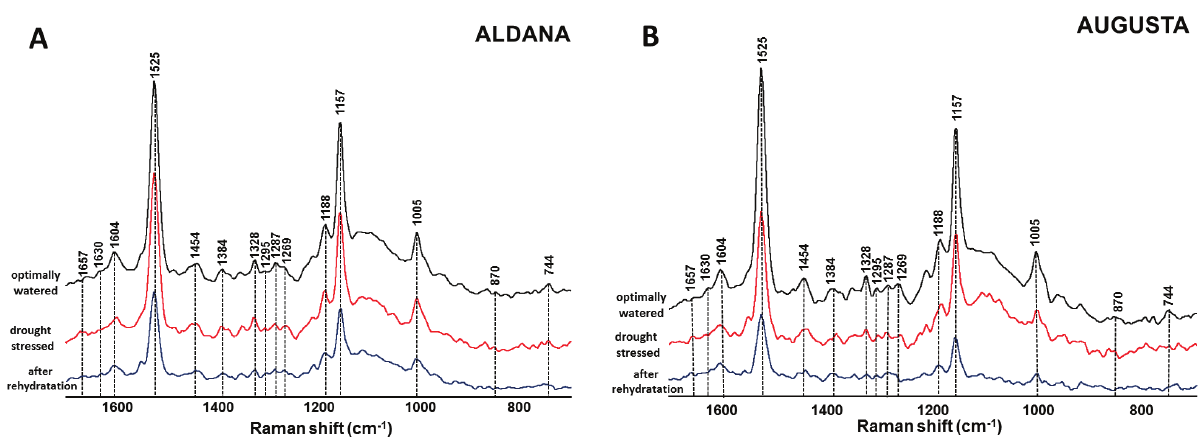
Figure 1: FT-Raman spectra of leaves of soybean (A) cv. Aldana and (B) cv. Augusta collected from optimally watered, drought-stressed and rehydrated